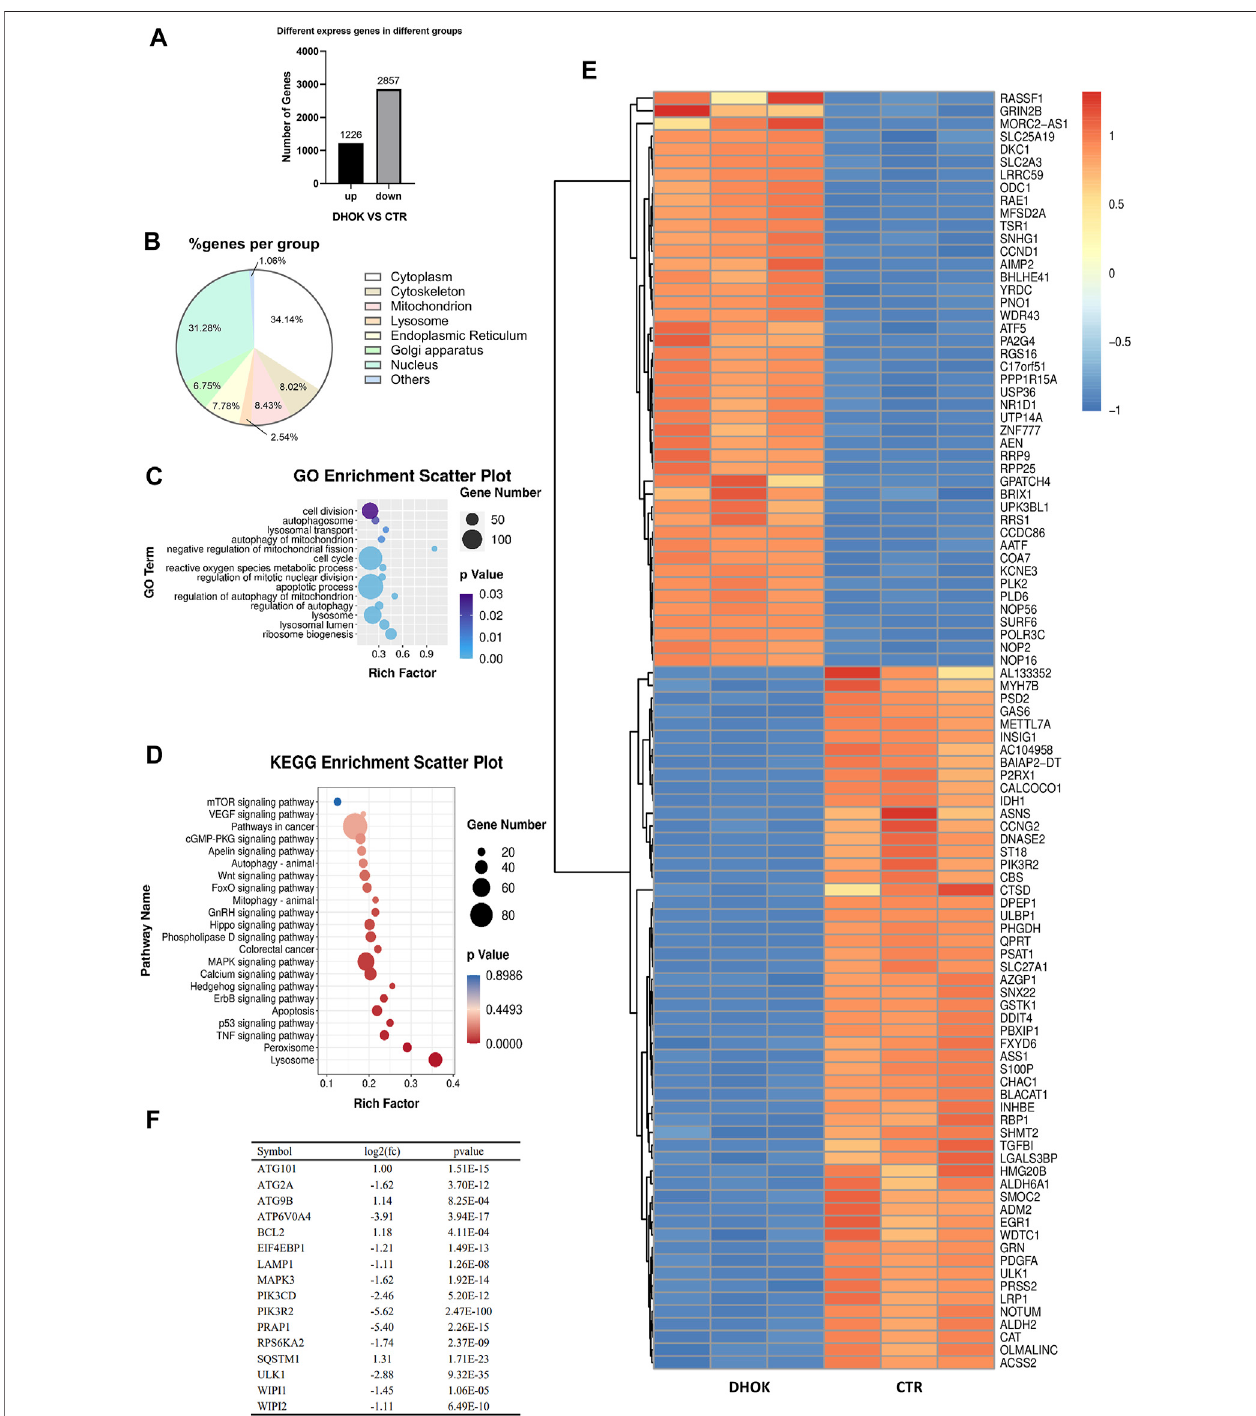
FIGURE2| DHOKexertsaninhibitoryeffectonautophagy-relatedsignalingpathway.SW620cellsweretreatedwithDHOK(12.5 μ M,24 h)andharvestedforRNA extraction. Human gene expression was analysed using transcriptome sequencing. (A) The number of signi fi cant differential expressed gene. (B) Cellular localization of theDHOKtargetswasshowninGOanalysis. (C) GOenrichmentanalysisscatterplot.Thesizeofblackcirclewasmeanttotheunigenenumberanddifferentcolorswere meant to different p values. (D) KEGG enrichment of signaling pathways in DHOK-treated cells. Red and blue color refered to the upregulated and downregulated genes,respectively.Thefoldchangeswerealsodescribedonthetop-rightcorner. (E) Heatmapofthedifferentiallyexpressedgenes. (F) Listofautophagy-relatedgenes that have signi fi cant changes.